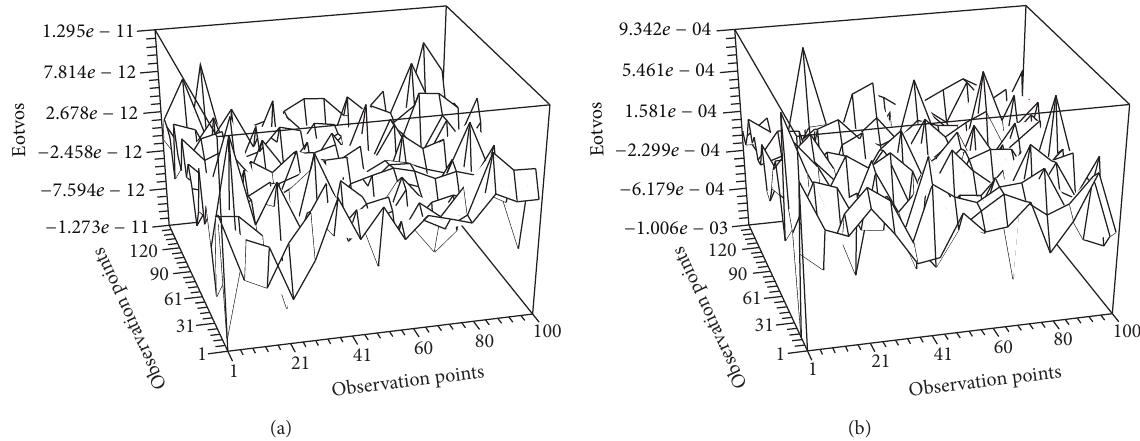
Figure 21: Absolute error of the components 𝐺 𝑧𝑧 calculated using four C2070 cards in (a) double precision and (b) single precision with respect to double precision CPU-cluster